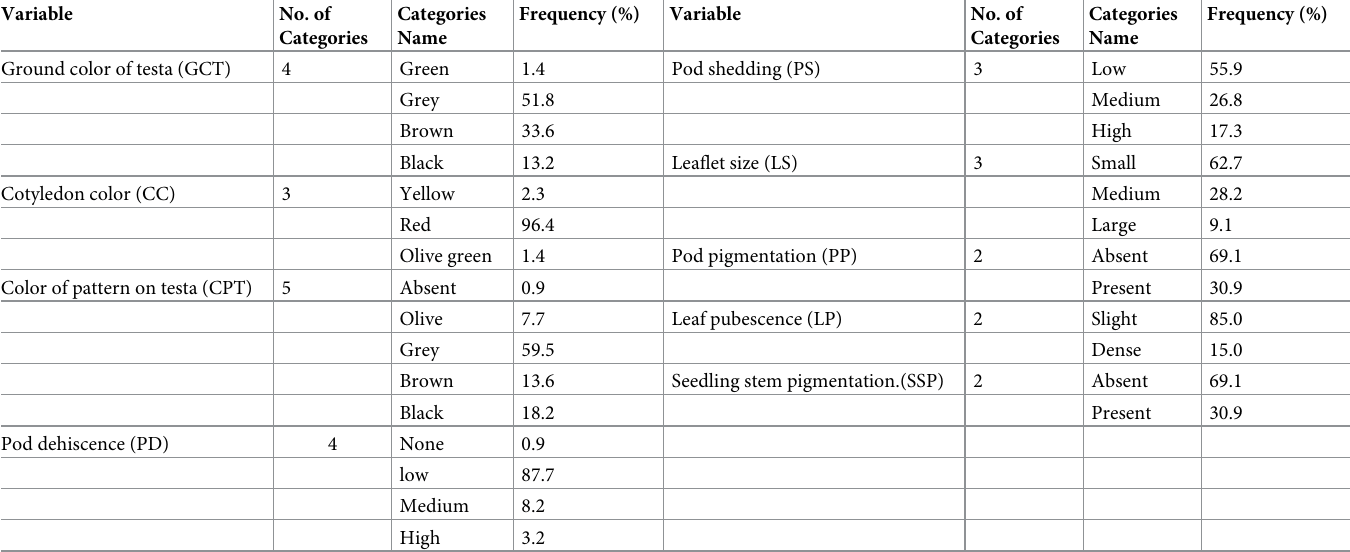
Table 3. Frequency distribution of qualitative traits of lentil germplasm studied during 2017–18 and 2018–19. Variable No. of